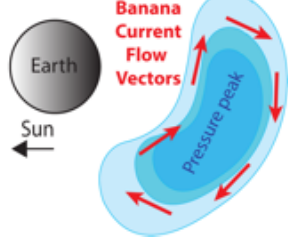
Figure 13. Schematic view of banana current system in the equato- rial